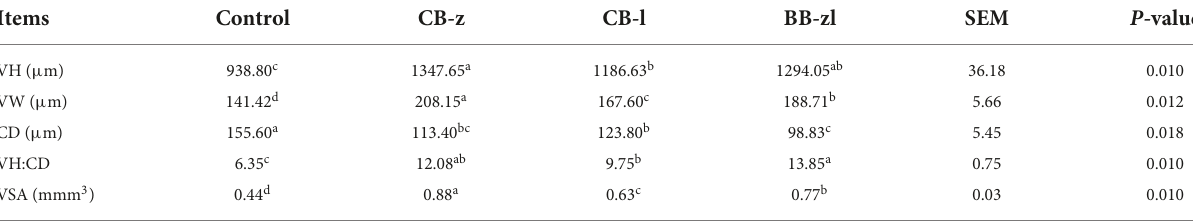
TABLE 8 Effects of Clostridium butyricum and Brevibacillus sp. on the jejunal villi morphometry of laying